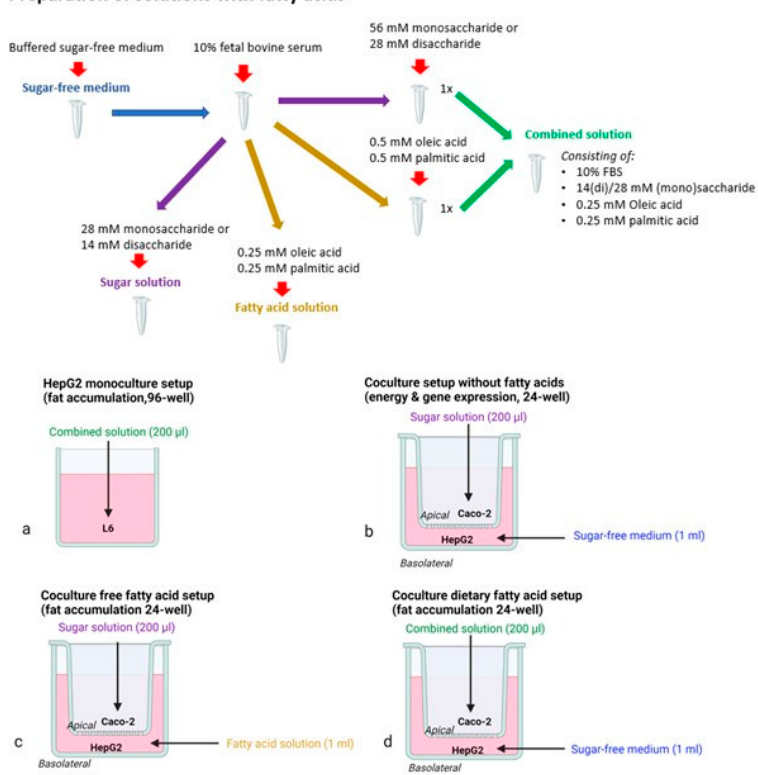
Figure 2. Experimental setups and exposure preparations (Biorender). These setups include a monoculture setup ( a ) and coculture setup: without fatty acids ( b ), free fatty acid setup ( c ) and a dietary fatty acid setup ( d ).